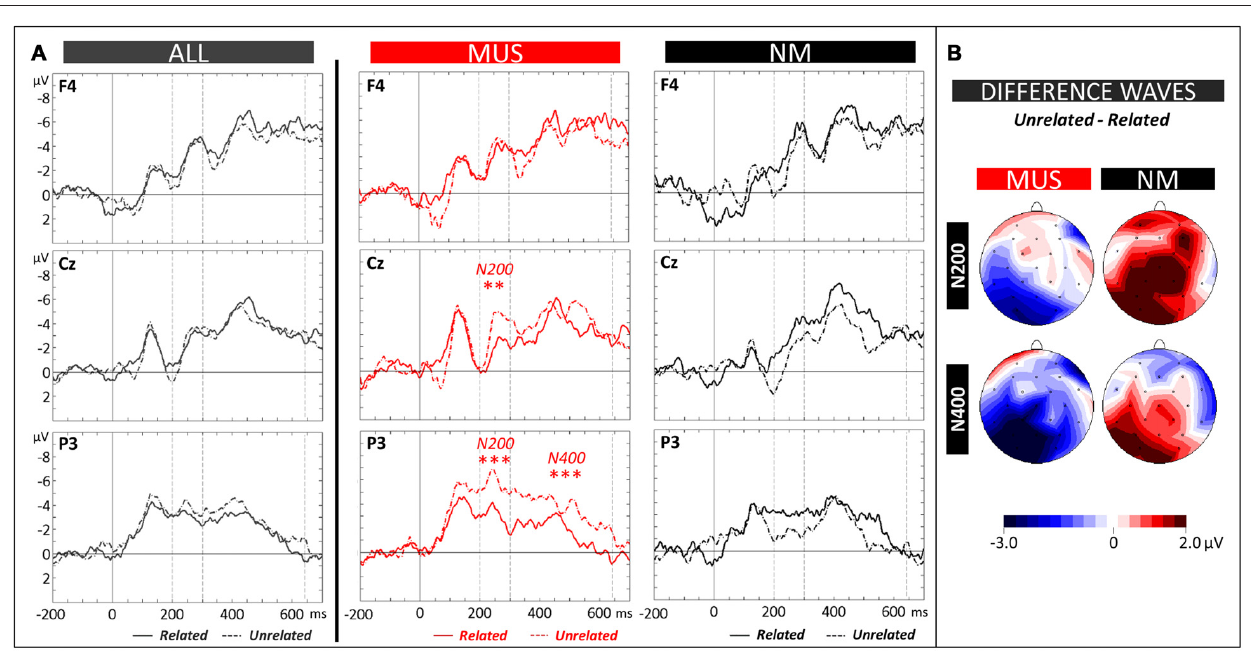
FIGURE 6 | Semantic task. (A) ERPs recorded at representative electrodes (right frontal (F4), central (Cz) and left parietal (P3)) are overlapped for Related (solid lines) and Unrelated words (dotted lines), averaged across all children (ALL, dark gray lines) and for musician (MUS, red lines) and non-musician children (NM, black lines). Mean number of trials contributing to the averages (ALL = 730, MUS = 380, NM = 350). (B) Topographic voltage distribution maps of the differences between conditions (Unrelated minus Related) are illustrated for the N200 and N400 and for MUS and NM. Voltage values are scaled from –3.0 µ V to +2.0 µ